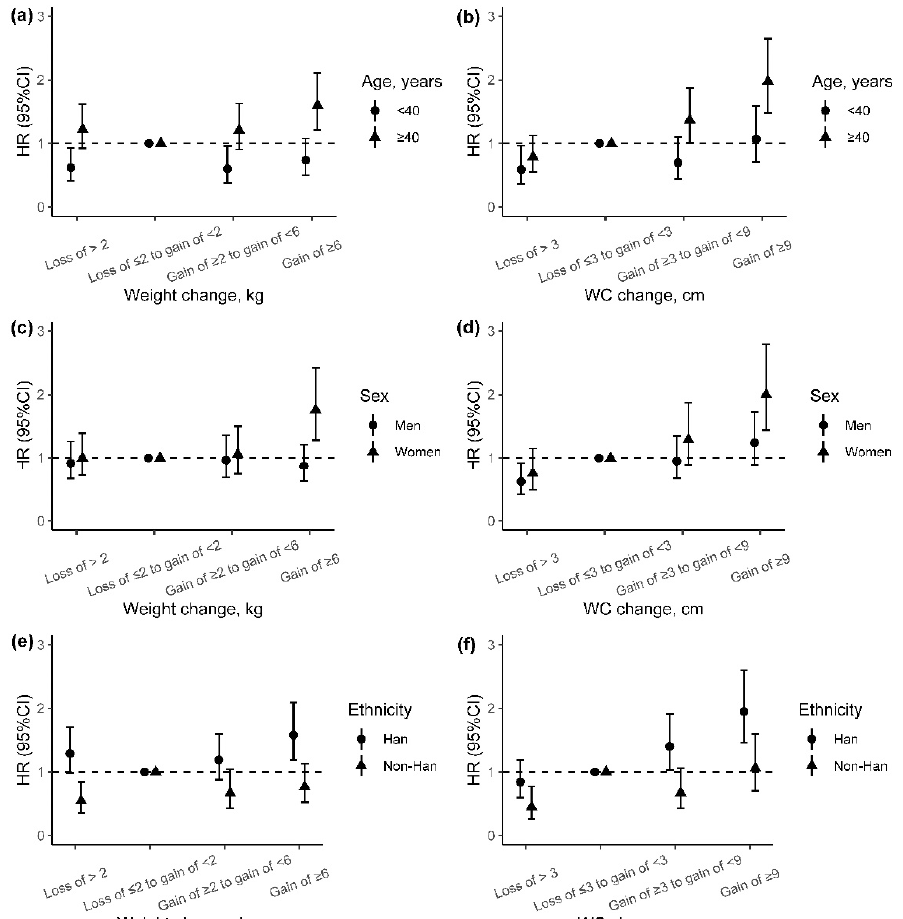
Figure 3. The incident risk of T2DM associated with adiposity changes from baseline to follow ‐ up by age, sex, and ethnic group. ( a , b ) Association between weight or WC change with risk of incident T2DM by age; ( c , d ) association between weight or WC change with risk of incident T2DM by sex; ( e , f ) association between weight or WC change with risk of incident T2DM by ethnicity. Adjusted for age (continuous variable), sex, ethnicity, education, marriage, occupation, smoking status, alco ‐ hol use, physical activity, history of hypertension, history of dyslipidemia, IGR, and baseline BMI value (in the analyses of weight change) or baseline WC value (in the analyses of WC change). HR, hazard ratio; 95%CI, 95% confidence interval; WC, weight circumference. 4. Discussion Based on a prospective cohort study in Southwest China, we found that general and abdominal adiposity indicators were strongly associated with the risk of incident T2DM in adults, and the associations of the latter were stronger. Using longitudinal measures of weight and WC at baseline and follow ‐ up, this study provided evidence that per SD in ‐ crease in weight and WC changes were associated with a higher risk of T2DM. Restricted cubic splines suggested the non ‐ linear relationships for weight change and WC change with incident T2DM. Furthermore, we found that weight and WC gain during midlife and later life (after 40 years of age) were important risk factors for T2DM. The observed asso ‐ ciations were also stronger among women and Han Chinese than men and non ‐ Han Chi ‐ nese. Previous cohort studies or meta ‐ analyses have demonstrated that adiposity indica ‐ tors such as BMI, WC, and WHtR were the strongest modifiable risk factors of T2DM [10,20,25,26]. In this study, the HR of incident T2DM was increased with the increment of